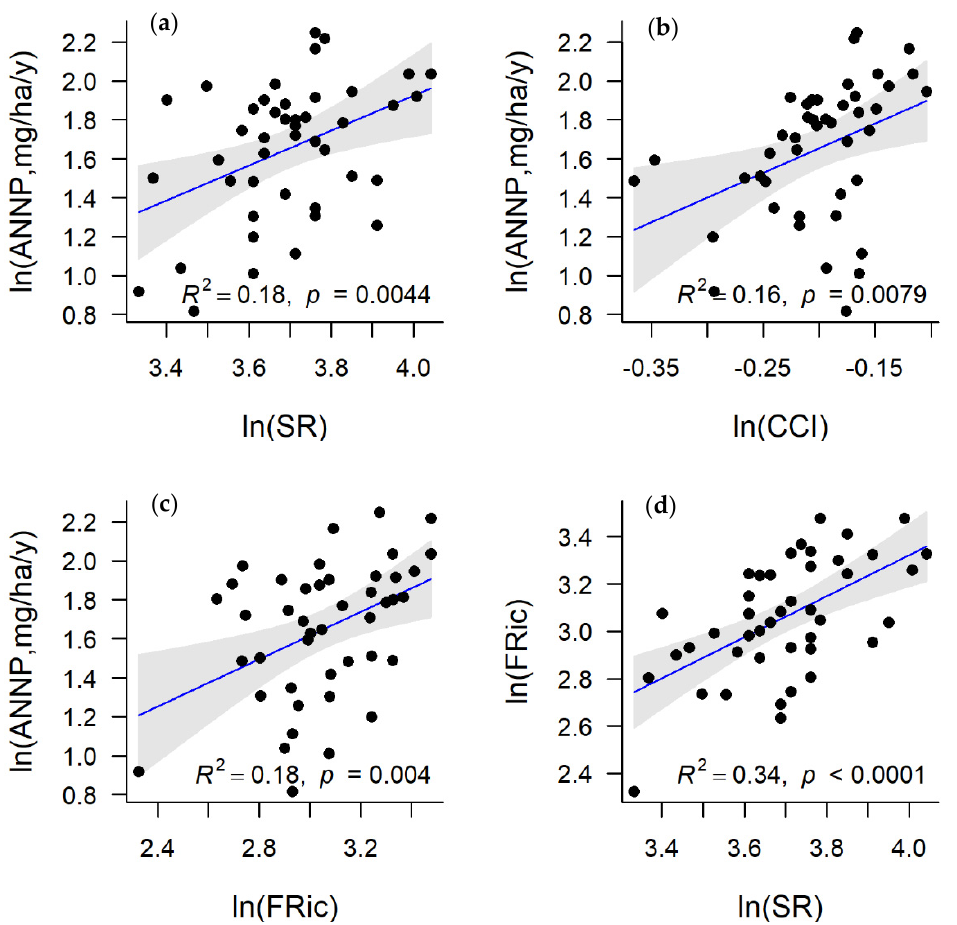
Figure 3. Linear relationships between endogenous and exogenous variables (n = 44 quadrats). The upper three scatter plots ( a – c ) capture annual forest productivity (ANPP) versus species richness (SR), crown complementarity index (CCI) and functional diversity (FD), respectively; and ( d ) measures functional diversity (FD) regressed on species richness (SR). The R 2 and p -values are shown. All numerical variables were natural log-transformed.